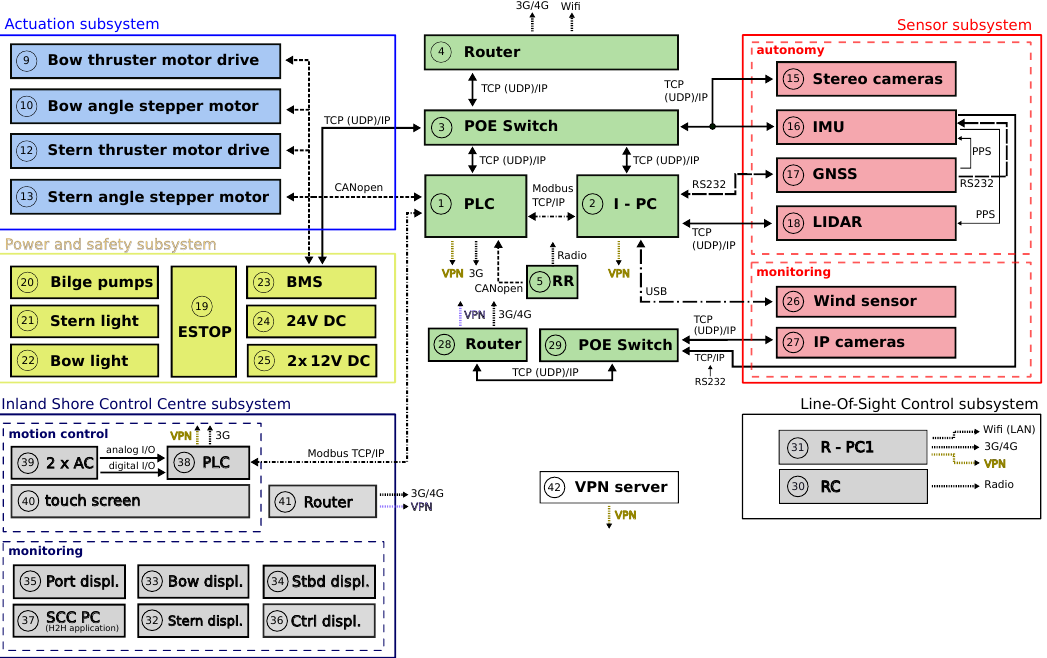
Figure 7. Main I-SCC and USV components and their communication